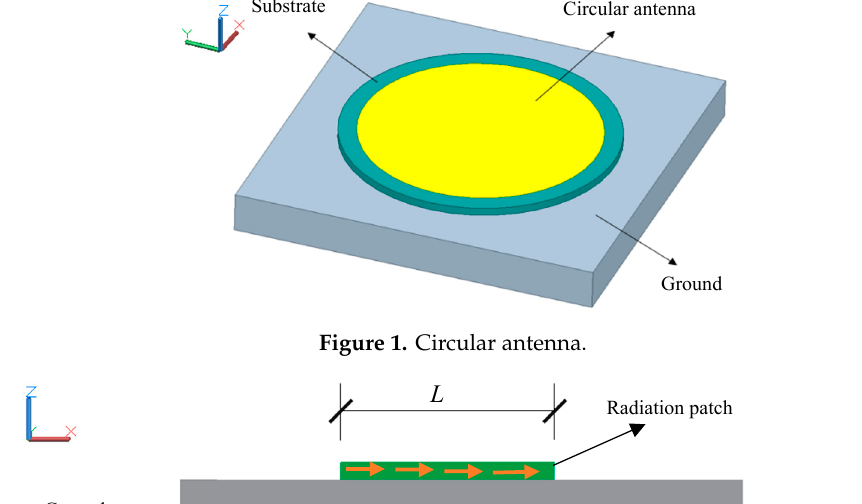
Substrate Circular antenna